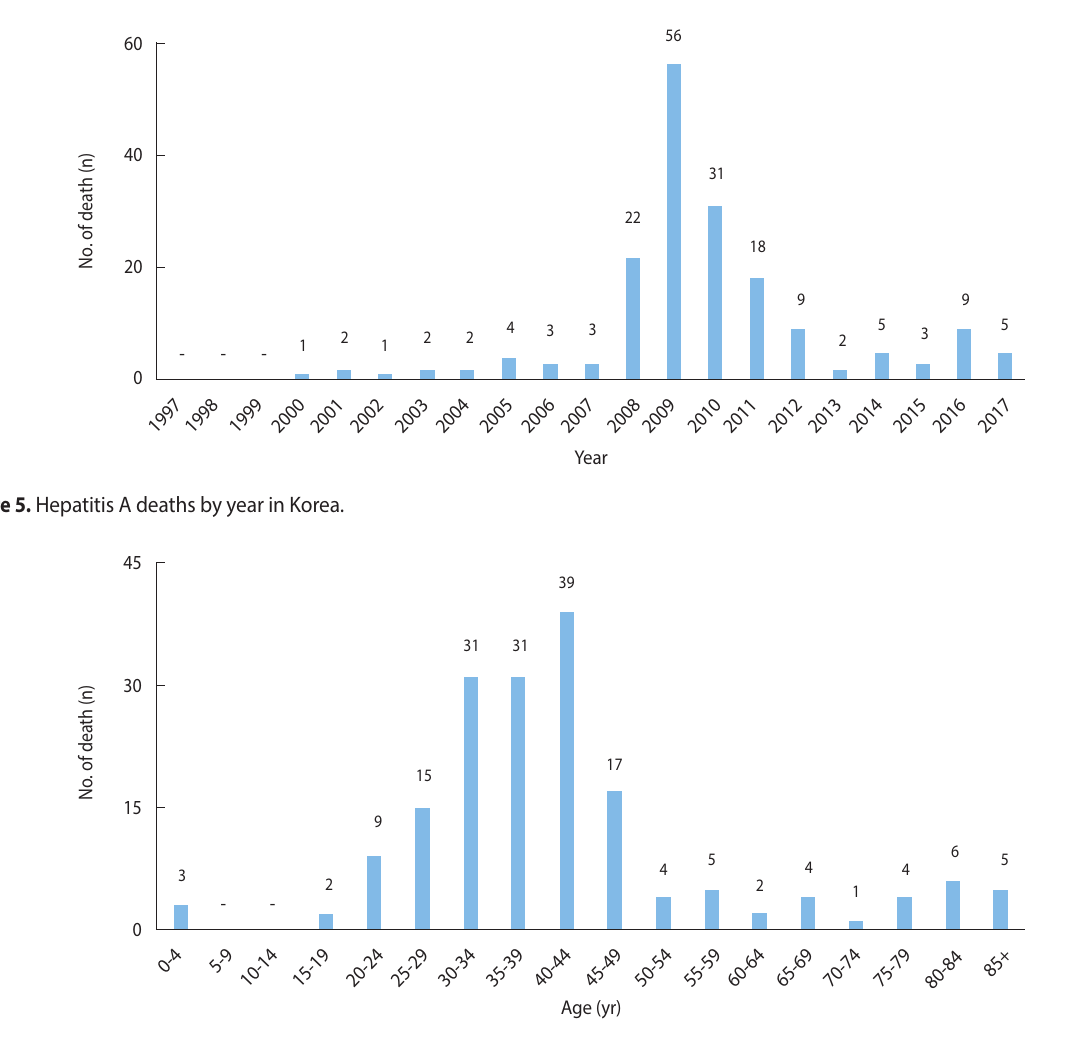
Figure 6. Age distribution of hepatitis A deaths in Korea, 2000-2017. Table 1. Area and sex-adjusted seroprevalence (%) of anti-HAV from 2005 to 2014, in Korea 1